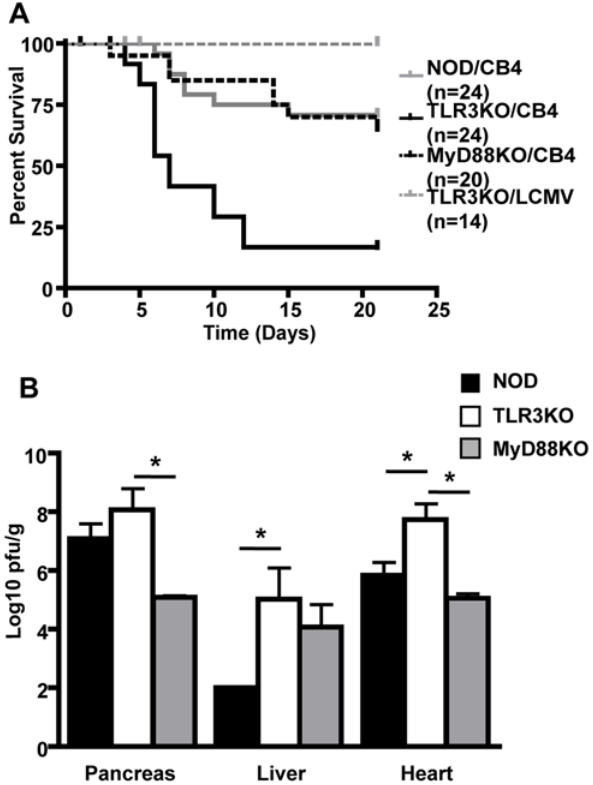
Figure 1. Deficiency of TLR3 results in increased mortality and increased viral replication following CB4 challenge. A) WT NOD (solid grey line), TLR3KO (solid black line) and MyD88KO mice (dashed black line) were challenged with 400 pfu of CB4 and mortality was monitored. TLR3KO mice were also challenged with 1 6 10 5 pfu of LCMV (dashed grey line) as an additional control. Significantly decreased survival was observed for TLR3KO mice challenged with CB4 compared to all other mouse strains and treatment tested. B) Mice were sacrificed at day 7 PI and viral load from the pancreas liver and heart of WT NOD (black bars, n=8), TLR3KO (white bars, n=5) or MyD88KO (grey bars, n=6) mice were measured by standard plaque assay. The viral titers are presented as log10 pfu/g of tissue and represent the average values of duplicates from at least 4 mice in each group. Stars denote statistical